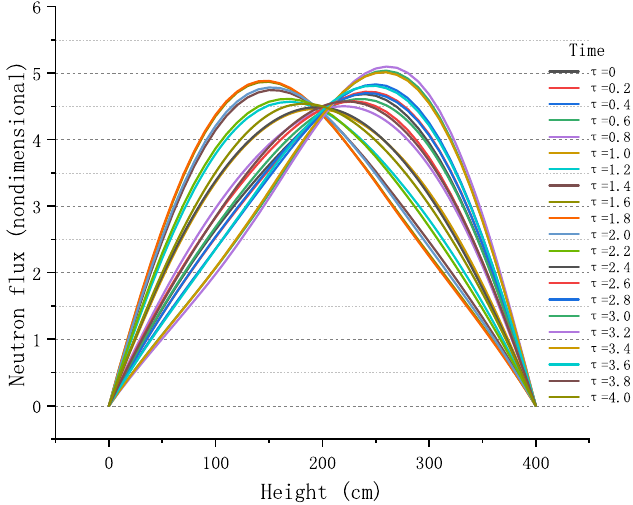
Fig. 6. The oscillation of neutron fl ux in 1 group model with the Doppler effect b =